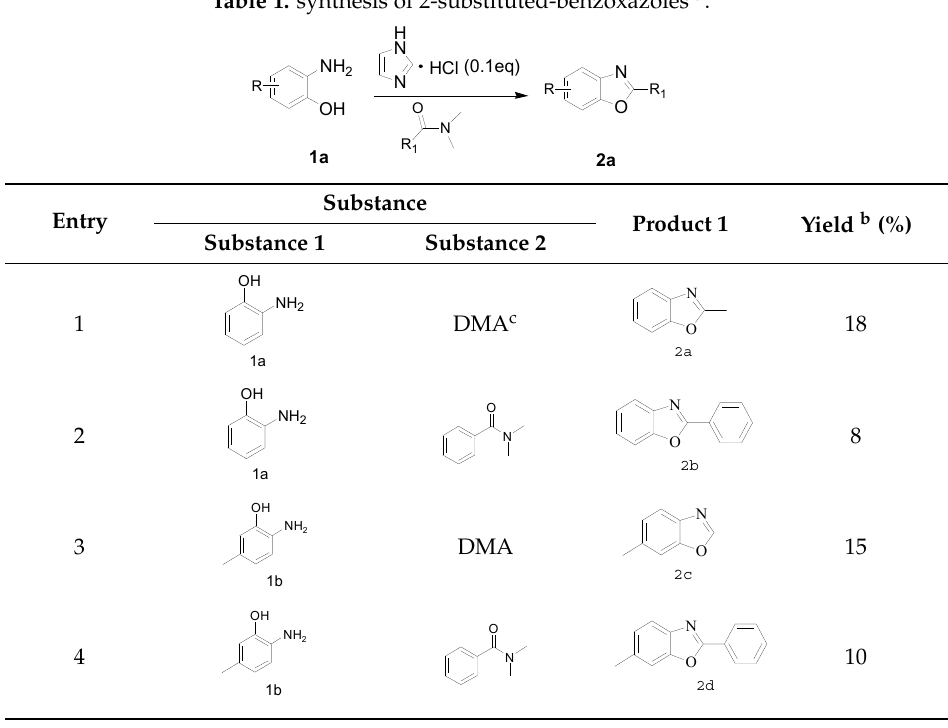
Table 1. synthesis of 2-substituted-benzoxazoles a.